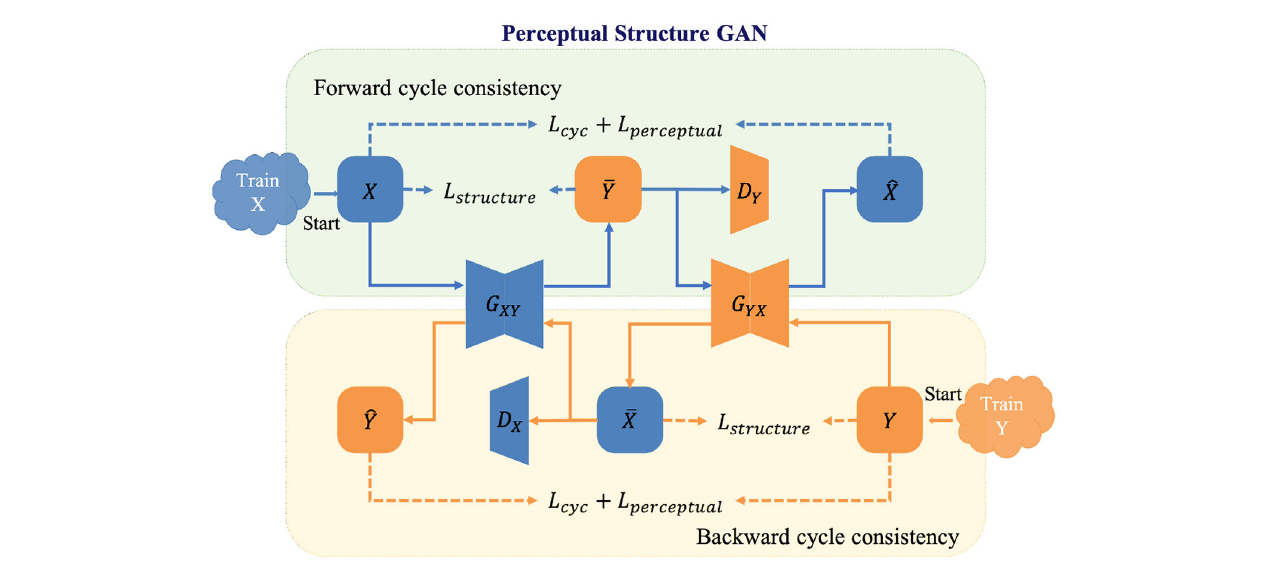
FIGURE4 Illustration of the perceptual structure GAN (PS-GAN) for the re-enhancing